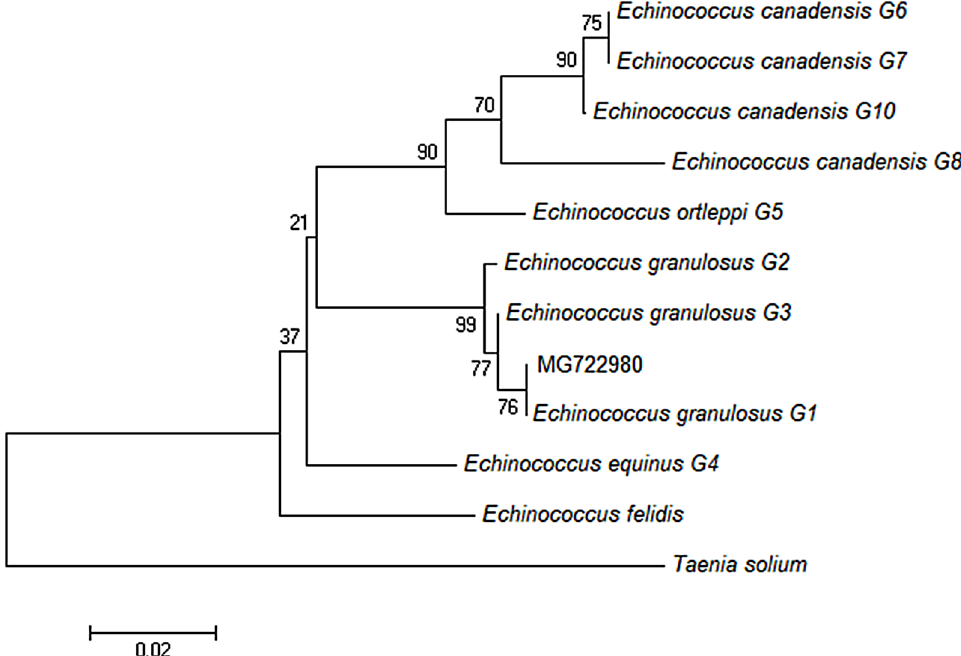
Figure 3. Phylogenetic tree constructed by the Neighbour-Joining method based on partial nucleotide sequences of the cytochrome oxidase subunit1 ( cox1 ) mitochondrial gene of Echinococcus granulosus sensu lato ( s.l .). The phylogenetic analysis includes the sequence recovered from the domestic cat (MG722980) and GenBank sequences of E. granulosus s.l . of different genotypes: E. granulosus sensu stricto ( s.s .) genotype1 (G1) (JF513058), E. granulosus s.s . G2 (JF513059), E. granulosus s.s . G3 (JF513060), E. equinus G4 (AF346403), E. ortleppi G5 (AB235846), E. canadensis G6 (AB208063), E. canadensis G7 (AB235847), E. canadensis G8 (AB235848), E. canadensis G10 (AB745463). A Taenia solium sequence (AY211880) was used as an